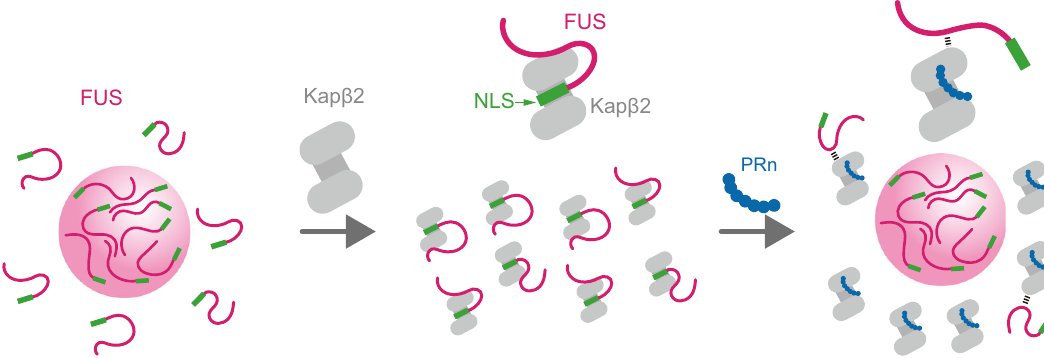
Fig. 6 Graphical abstract for the model of interaction between PR poly-dipeptides and Kap β 2. FUS is prone to self-associate (left). Kap β 2 modi fi es a phase transition of FUS by recognizing NLS (middle). PR poly-dipeptides partially bind to the NLS-binding site of Kap β 2 and impede its ability